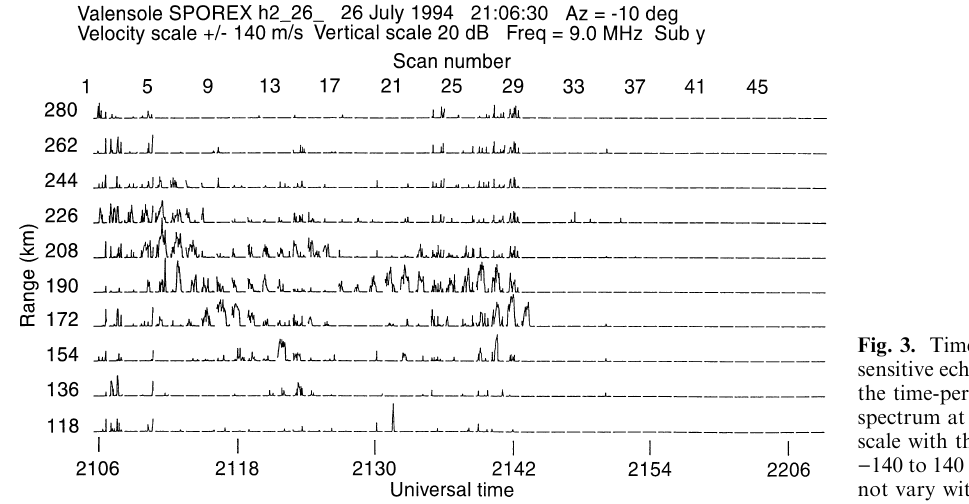
Fig. 3. Time evolution of E-region aspect sensitive echoes at 9 MHz in azimuth 10 (cid:176) W, in the time-period 2106–2209 UT. The Doppler spectrum at any cell is logarithmic on a 20-dB scale with the Doppler velocity ranging from ) 140 to 140 m/s. Note that the spikes which do not vary with range are due to interference